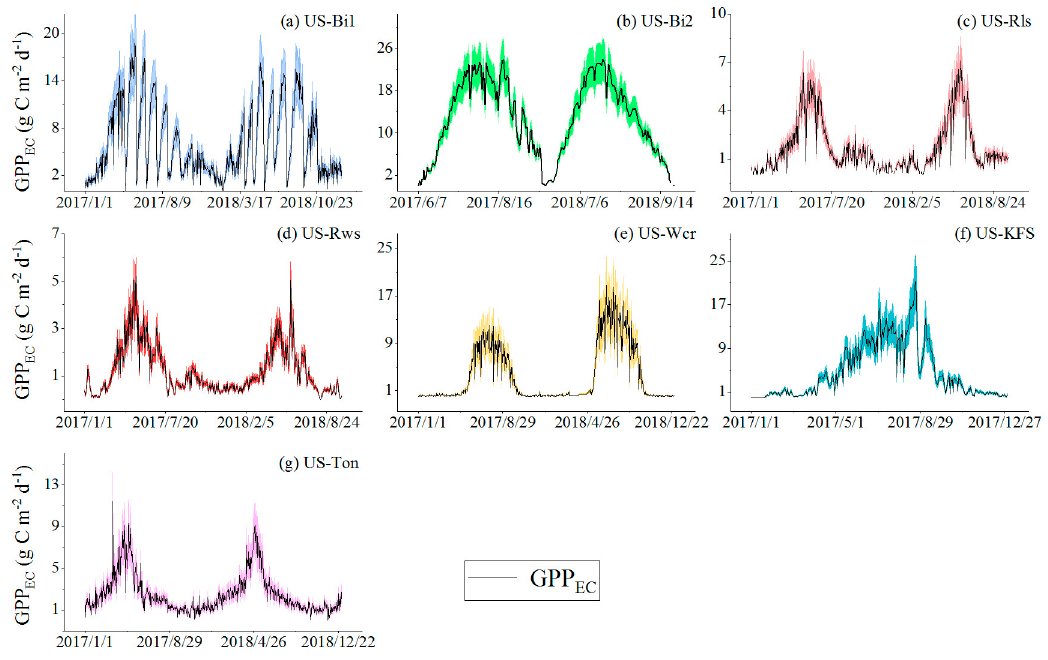
Figure 2. Temporal dynamics of the daily flux tower gross primary productivity (GPP EC ) at seven eddy flux tower sites in 2017 and 2018. Colored shadings denote the uncertainties. ( a ): alfalfa site, ( b ): corn site, ( c ): closed shrubland site, ( d ): open shrubland site, ( e ): deciduous broadleaf forest site, ( f ): grass site, ( g ): woody savanna site.